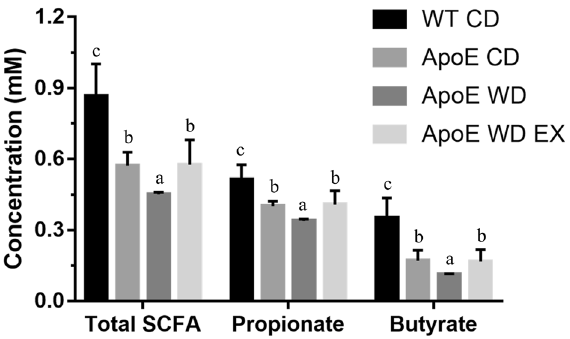
Figure 5. Effects of endurance exercise on fecal SCFAs in ApoE knockout mice. Values are mean ± SEM ( n = 6). Different superscript letters (a, b, and c) indicate significant differences ( P < 0.05) in one-way ANOVA.